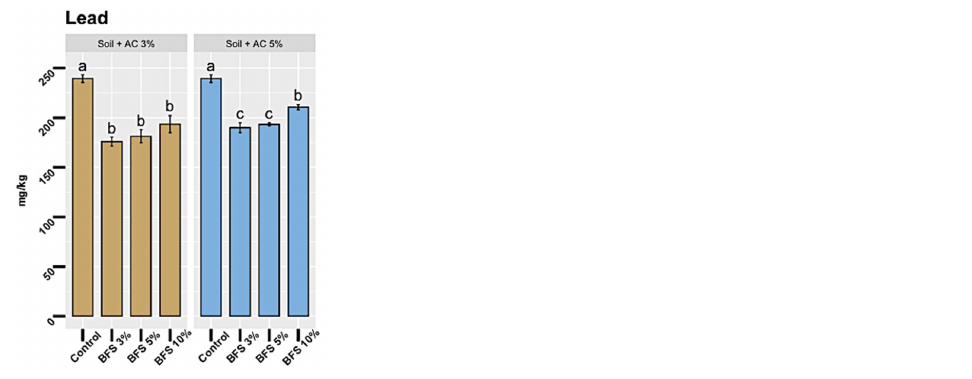
Figure 7. PTE content in soil with the amendment of Blast Furnace Slag (BFS) and Activated Carbon (AC).